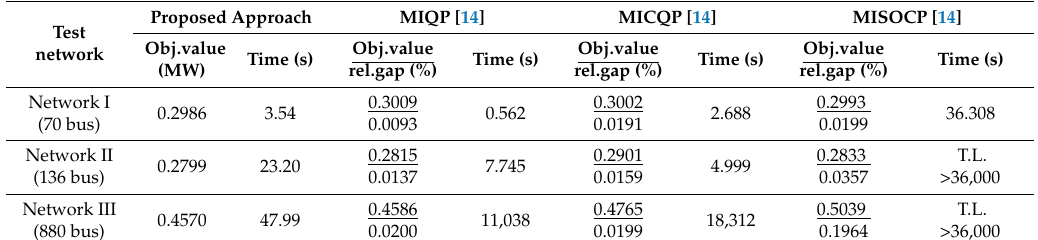
Table 3. Comparison of computational time for different